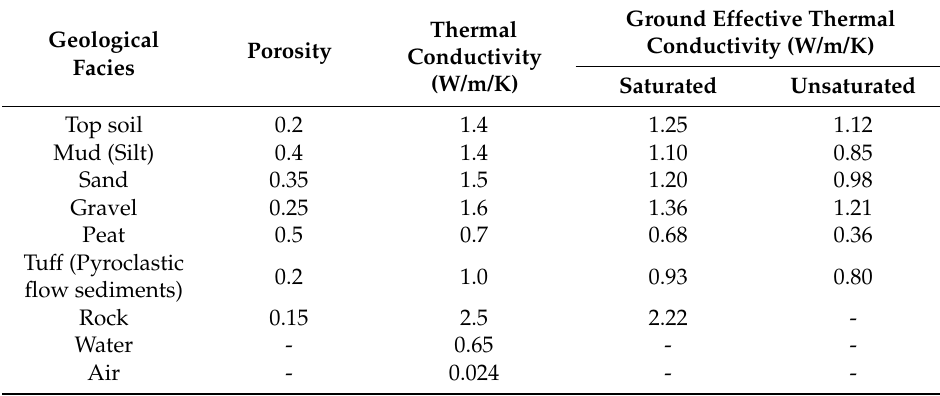
Table 1. Physical parameters of geological facies in the Aizu Basin. Geological facies were re-categorized from Shrestha et al. [10,11]. Porosity and thermal conductivity after Shrestha et al. [10,11]. Ground Effective Thermal Thermal Geological Conductivity (W/m/K) Porosity Conductivity Facies (W/m/K) Saturated Unsaturated Top soil 0.2 1.4 1.25 1.12 Mud (Silt) 0.4 1.4 1.10 0.85 Sand 0.35 1.5 1.20 0.98 Gravel 0.25 1.6 1.36 1.21 Peat 0.5 0.7 0.68 0.36 Tuff (Pyroclastic 0.2 1.0 0.93 0.80 flow sediments) Rock 0.15 2.5 2.22 - Water - 0.65 - - Air - 0.024 -